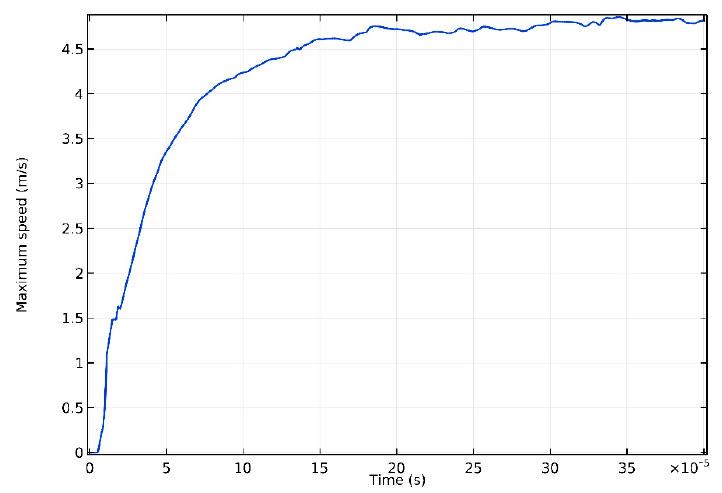
Figure 8. Maximum speed in the molten poll, at P = 100 W.